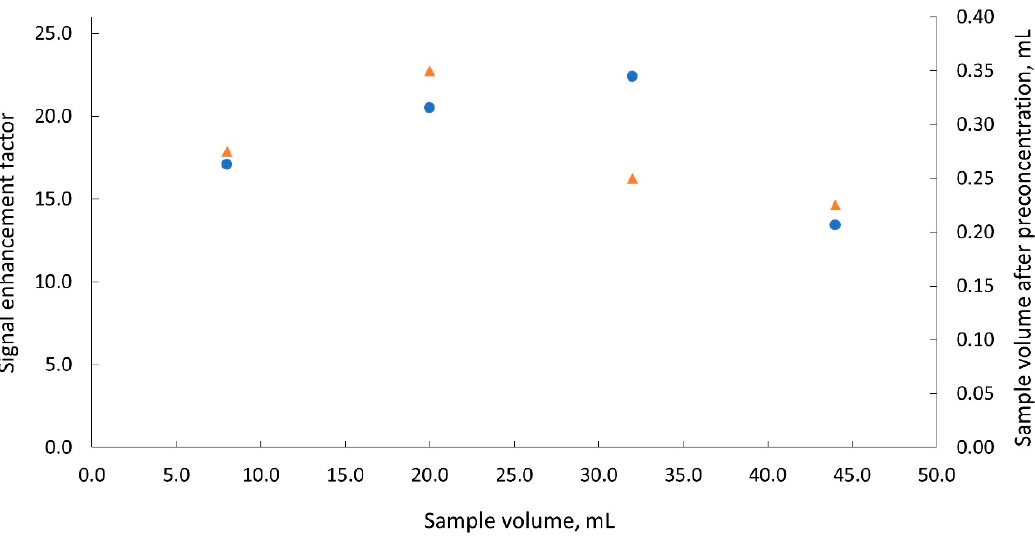
Figure 5. Dependences of the signal enhancement factor ( ● ) and of the sample volume collected after the evaporation process ( ▲ ) on the initial sample volume subjected to evaporation; dispensing flow rate 4 μ L s − 1 .